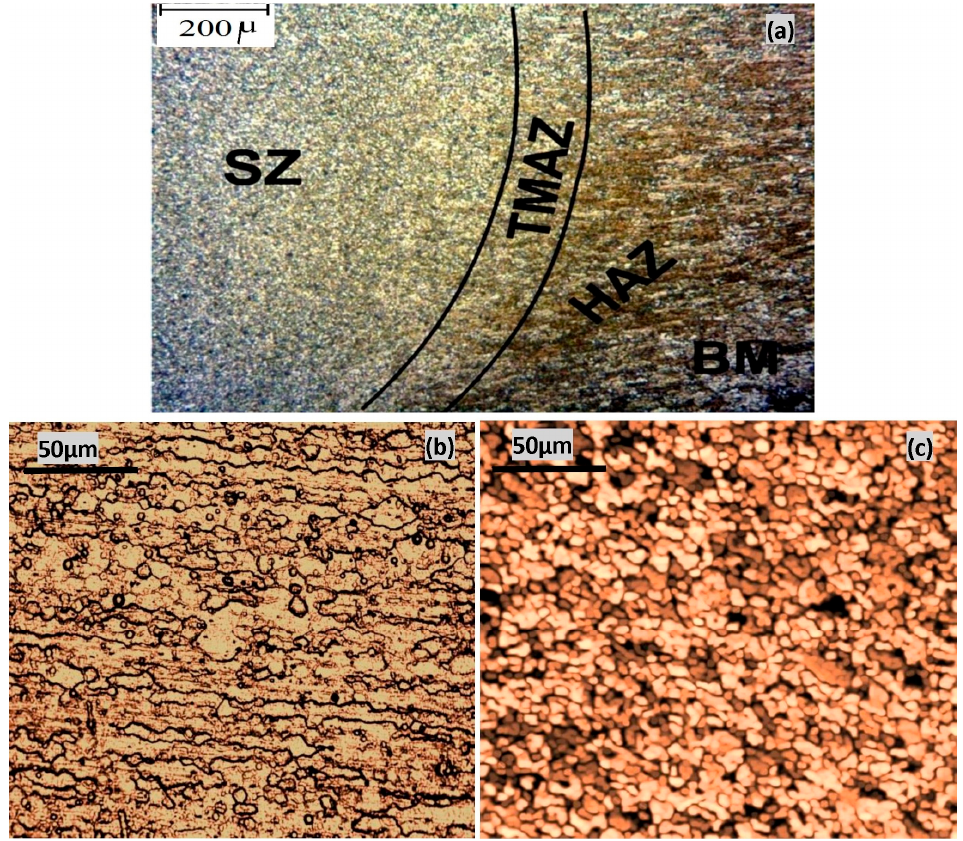
Figure 8. Microstructure of the grain distribution in the cross-section of the AA1100 FSW weld (processed at 1120 rpm and 250 mm / min); ( a ) general view of the cross-section, ( b ) stir zone (SZ) and ( c ) the base metal at higher magnification.